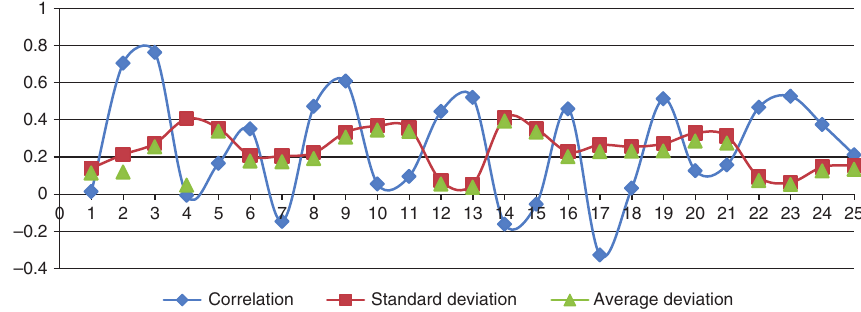
Figure 8: Lee et al. [21] Data Set – Result Analysis for Classes 0–1 Scores.